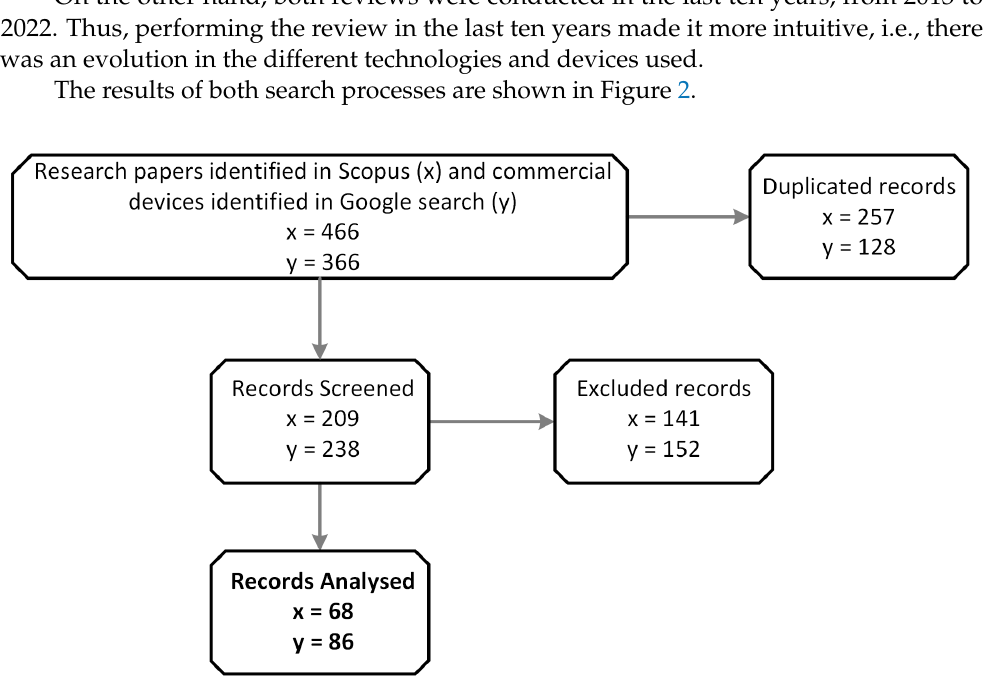
Figure 2. Searching phase